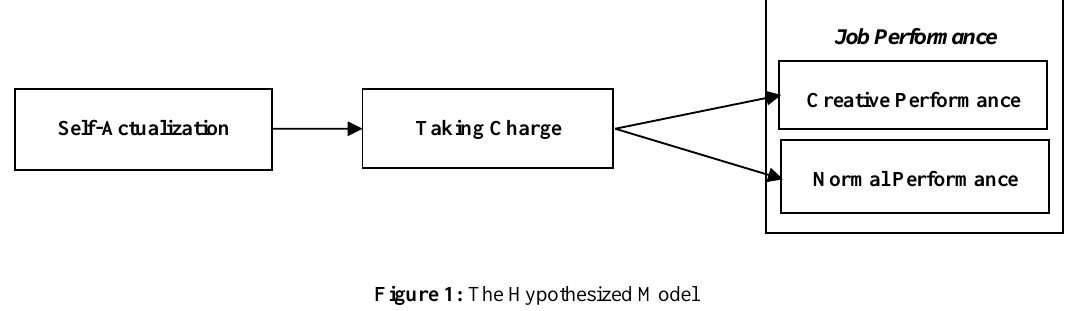
Figure 1: The Hypothesized